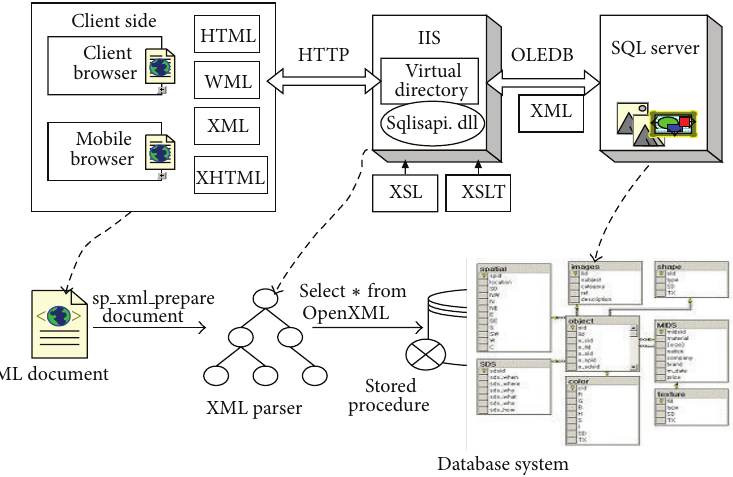
Figure 11: Process to store XML